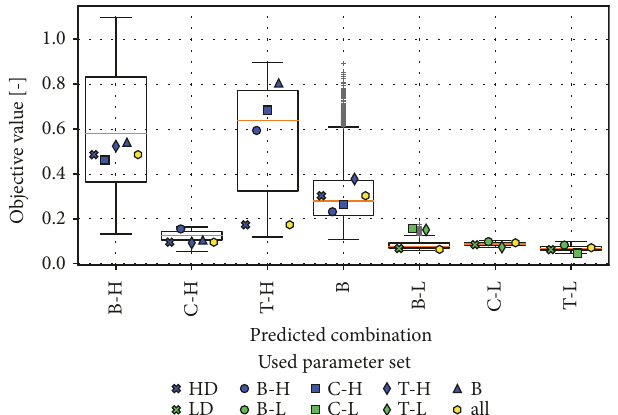
Figure 8: The distribution of the objective values per movement base case combination is displayed by the boxplots. The markers indicate, per used parameter set, how much the objective value would deviate from its optimum if the optimal parameter set, obtained using another (combination of) movement base case(s), would be used. The combinations are identified by their acronyms as found in Table